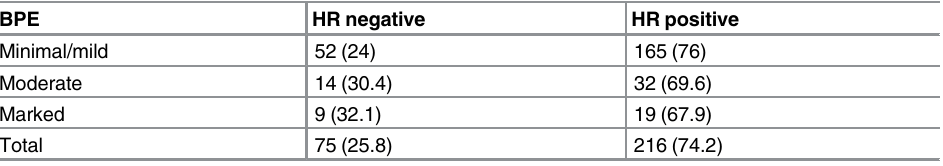
Table 4. Cross-tabulation of BPE and hormonal receptor status of malignant